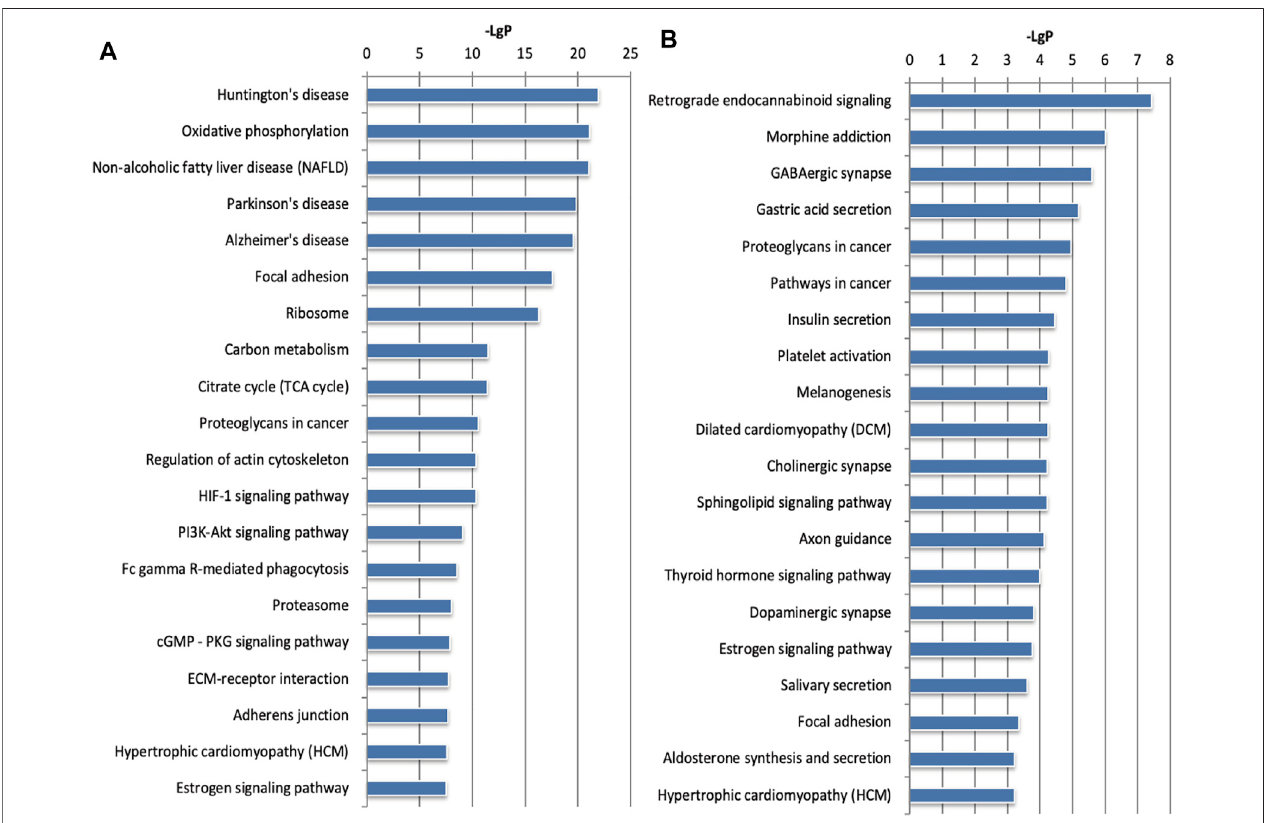
FIGURE 4 | KEGG pathway analysis for the mRNAs and microRNAs regulated by CIH. (A) KEGG pathway enrichment analysis for mRNAs. (B) KEGG pathway enrichment analysis for microRNAs. The abscissa is -LgP. The bigger the -LgP, the smaller the p -value.